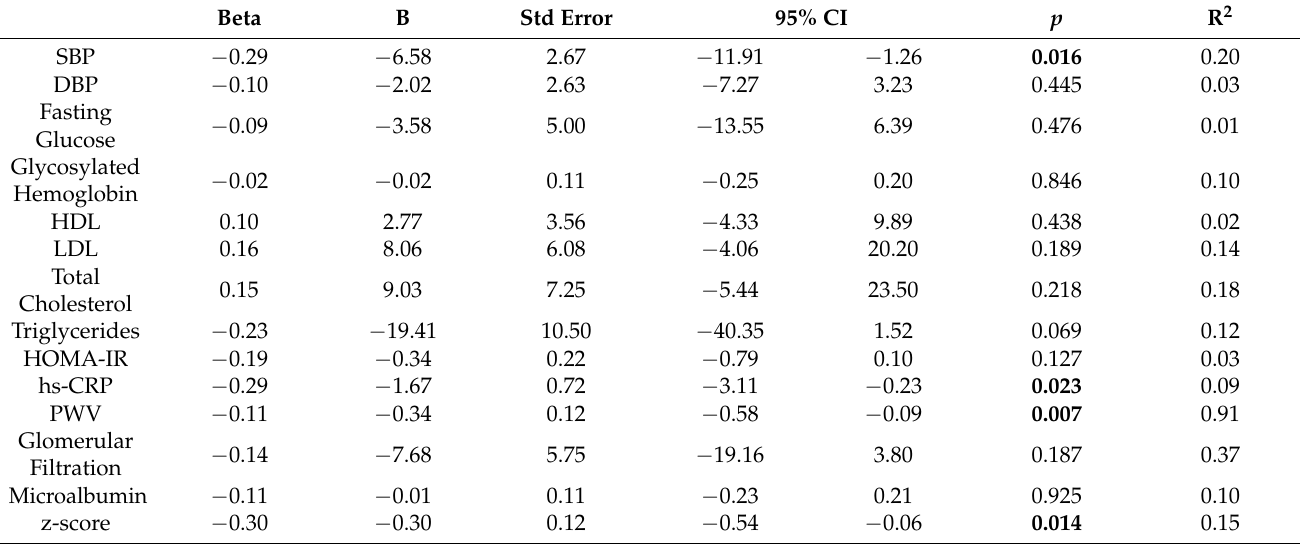
Table 3. Multivariable linear regression analysis evaluating the association of relative handgrip strength with cardiometabolic risk components in women with systemic lupus erythematosus ( n =